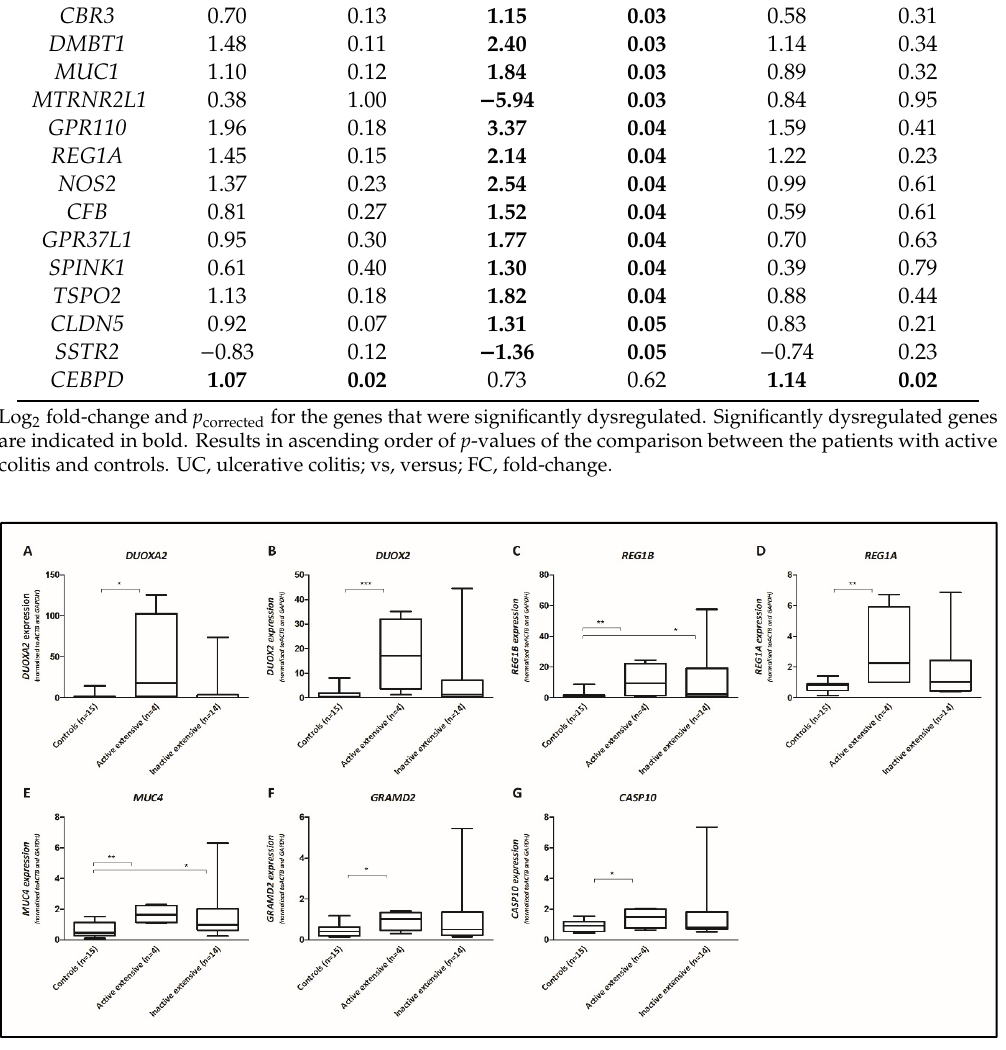
Figure 2. Validation of expression levels of seven selected mRNAs in ileal mucosal biopsies. Boxplots of the relative expression level of ( A ) DUOXA2 , ( B ) DUOX2 , ( C ) REG1B , ( D ) REG1A , ( E ) MUC4 , ( F ) GRAMD2 , and ( G ) CASP10 in controls ( n = 15), active extensive UC ( n = 4), and inactive extensive UC ( n = 14) patients, as assessed by qRT-PCR (box, 25–75%; whisker, min-max). The expression levels are normalized to the geometric mean of ACTB and GAPDH . Data were compared using the one-tailed Mann–Whitney U test (solid line with down angle, * p < 0.05; ** p < 0.01; *** p <